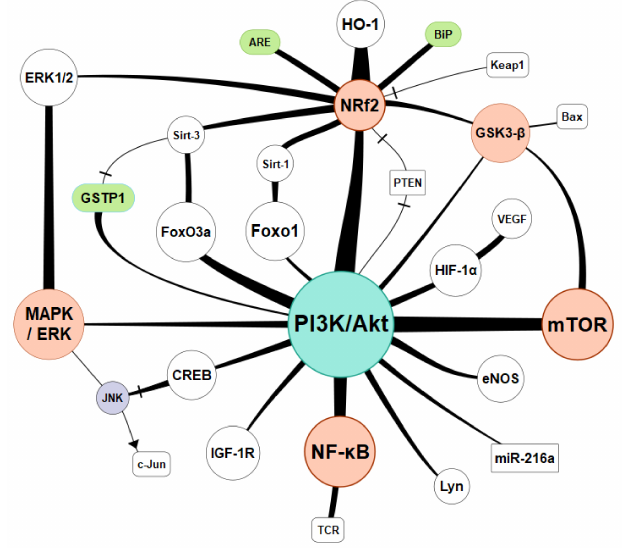
Figure 3. Basics of intracellular antioxidant mechanisms and nuclear signaling. Legend: